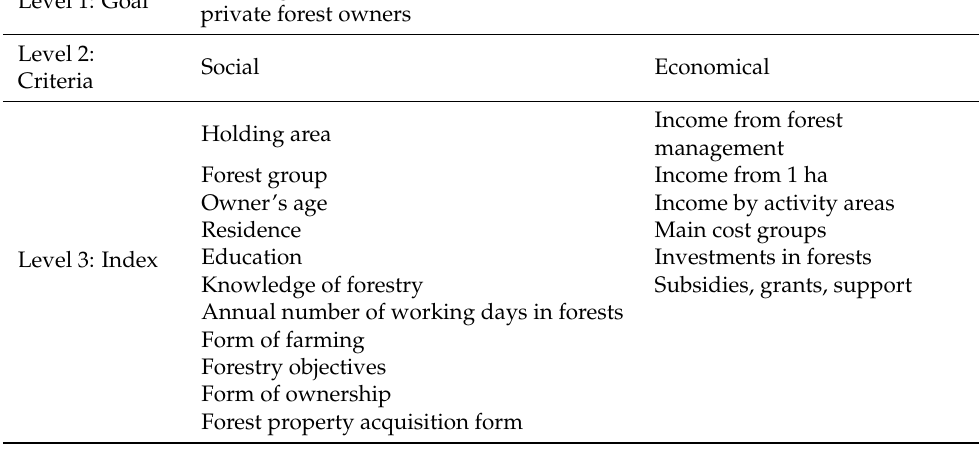
Table 2. Social and economic indicators for establishment of a database of the social and economic data of Lithuanian private forest owners.